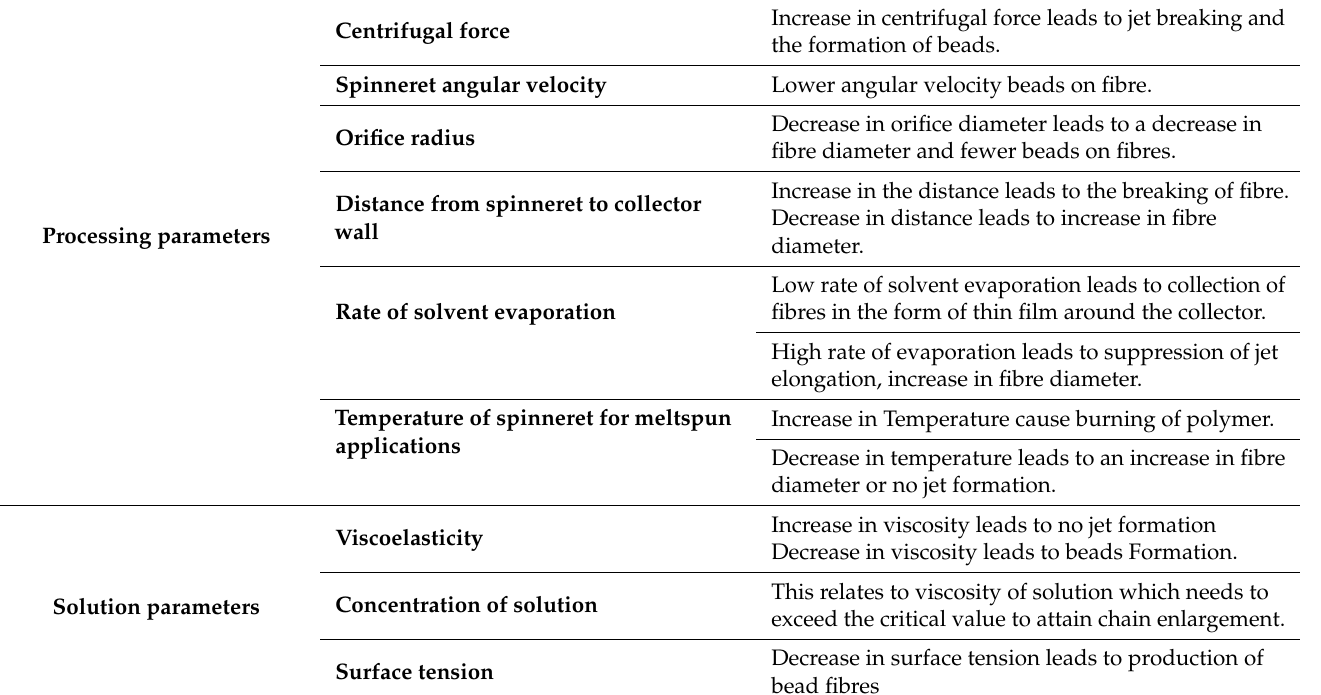
Table 6. Effect of different Parameters on centrifugal spinning process